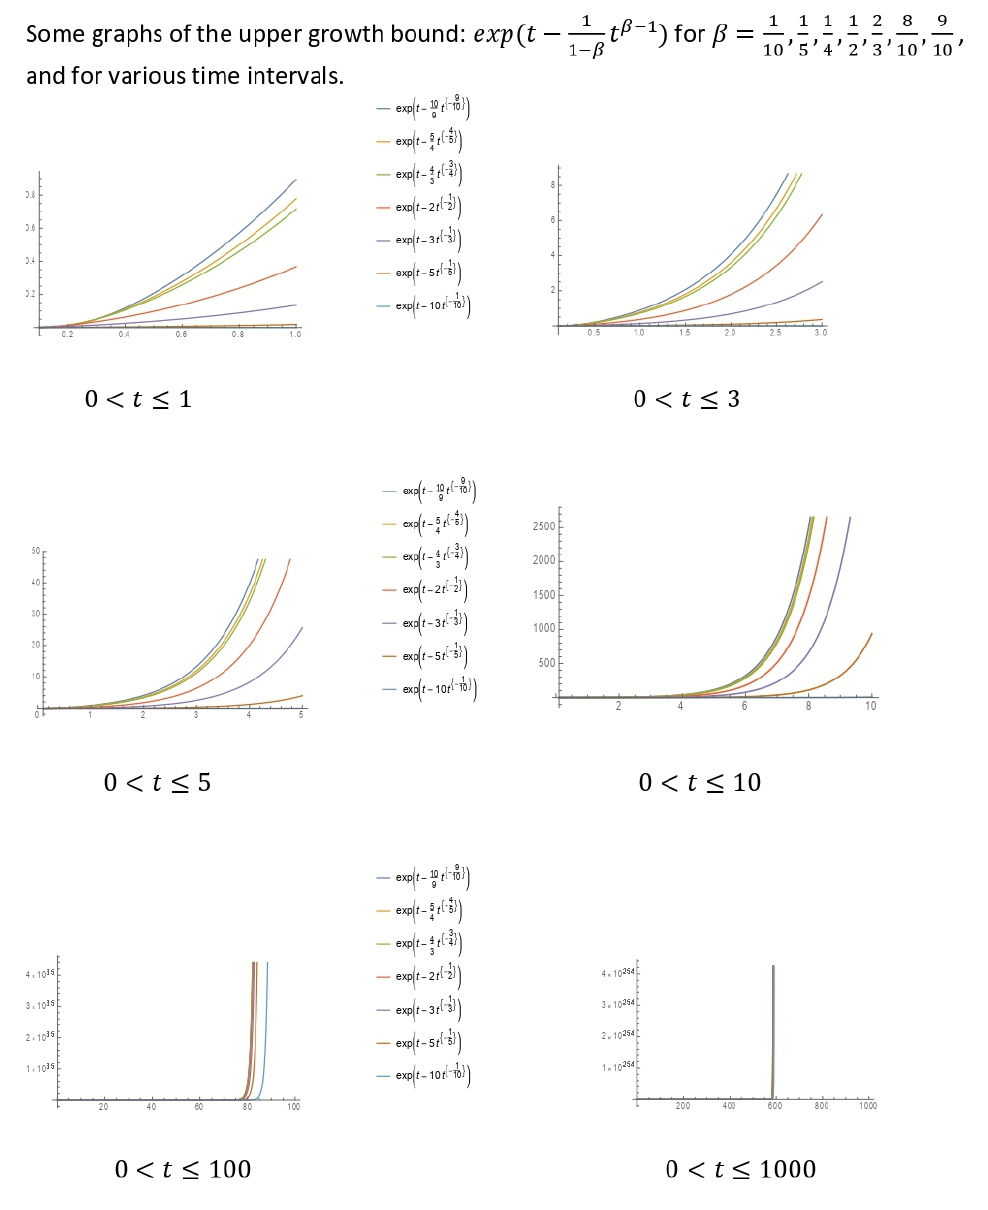
Figure 1. Graphical illustration of the growth